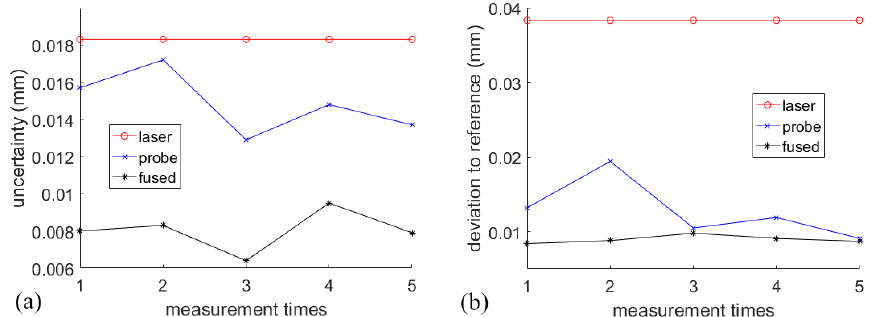
Figure 22. Repeated measurement results for: ( a ) uncertainty; and ( b ) deviation from the reference surface.